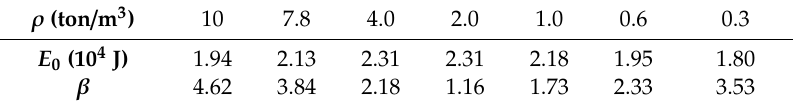
Table 5. Simulation results at plastic kinematic model.